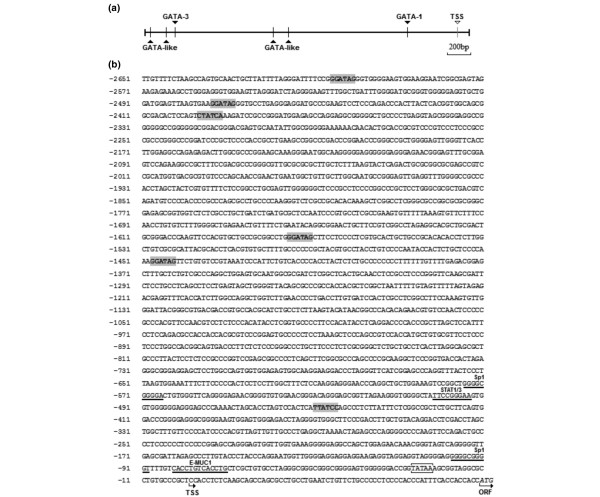
MUC1 promoter sequence. (a) GATA cis-elements map identified in MUC1 promoter region. (b) DNA sequence showing the TATA box (white box), the transcriptional start site +1 (TSS arrow) and the open reading frame (ORF arrow). Gray boxes indicate putative binding sites for GATA transcription factors showing the following: a GATA1 sequence (-448), a GATA3 sequence (-2395) and four GATA-like sequences (-1446, -1574, -2472, and -2604). Known regulatory elements are underlined (Sp1, STAT1/3, E-MUC1).